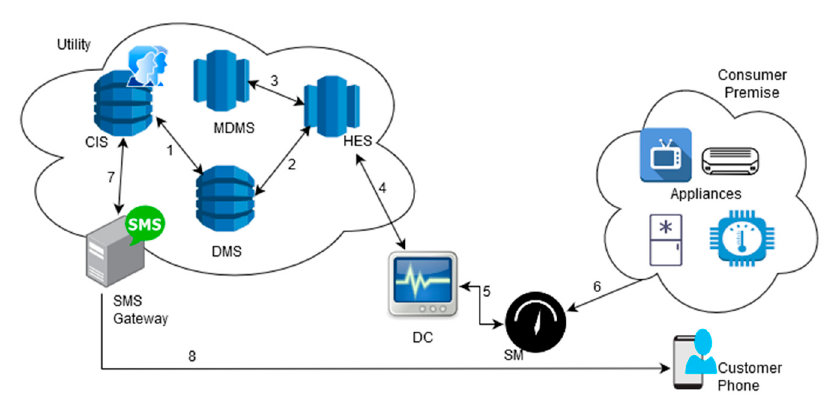
Figure 1. Infrastructure of the use case.